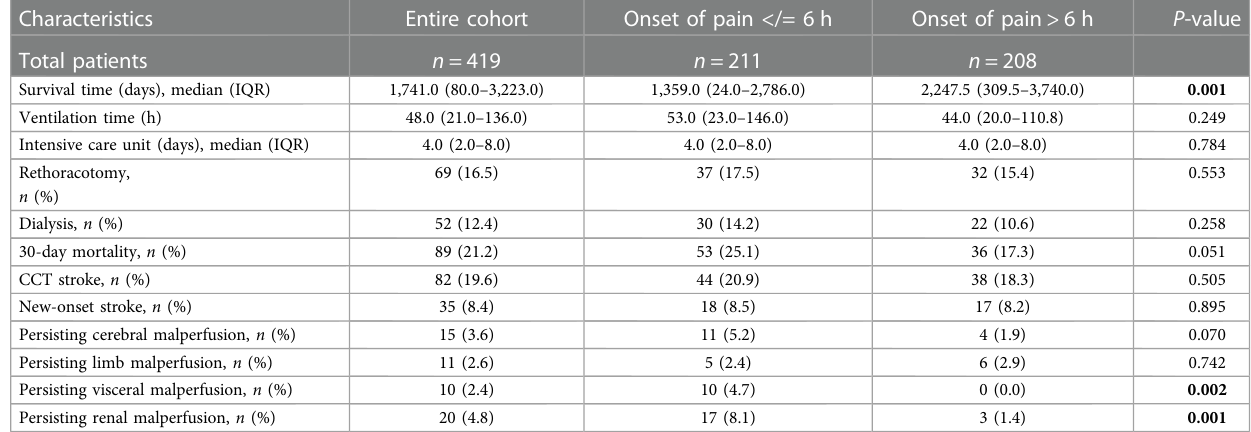
TABLE 4 Postoperative data: SD, standard deviation; IQR, interquartile range; min, minute; CCT, cranial computed tomography. Characteristics